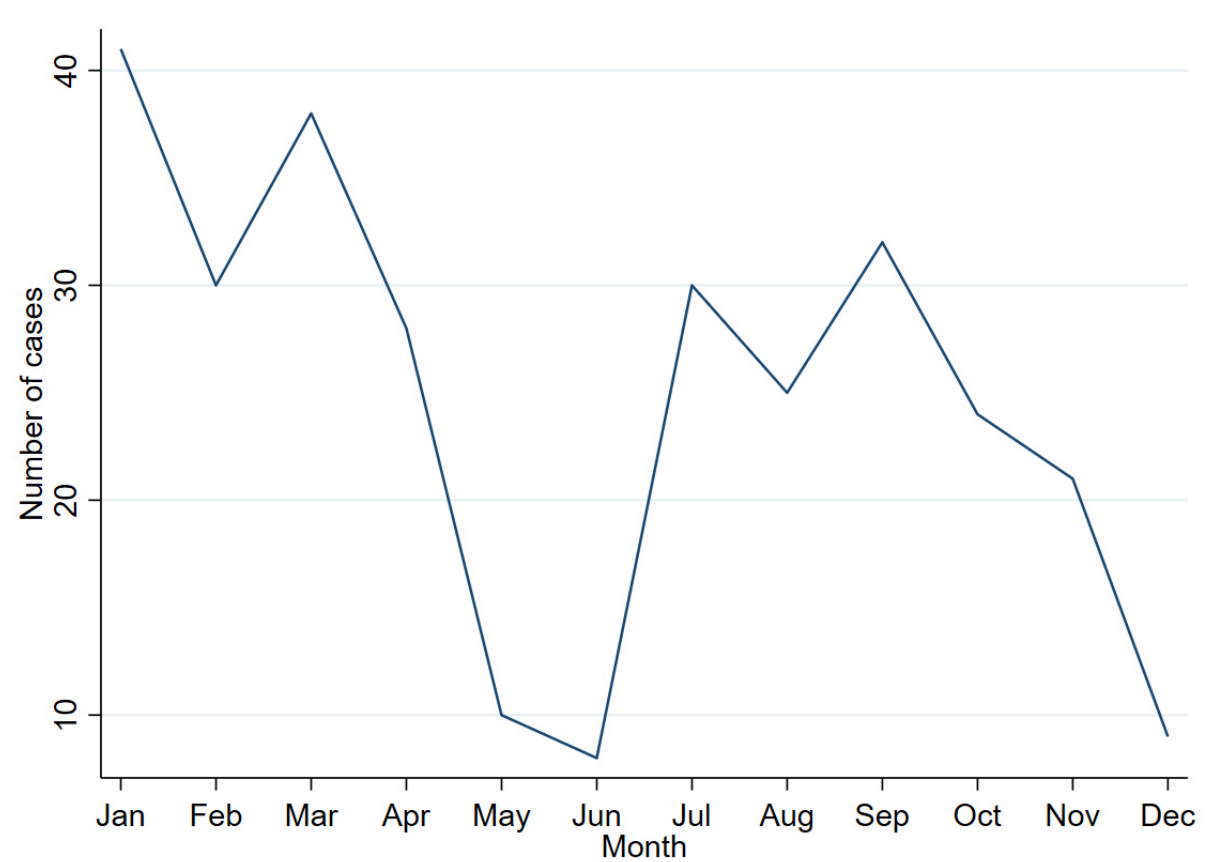
Figure 4. Monthly trend of the number of fever admissions at Samtse Hospital, Bhutan, 2020. Table 2. Aetiologies of fever admissions in Samtse Hospital, Bhutan,